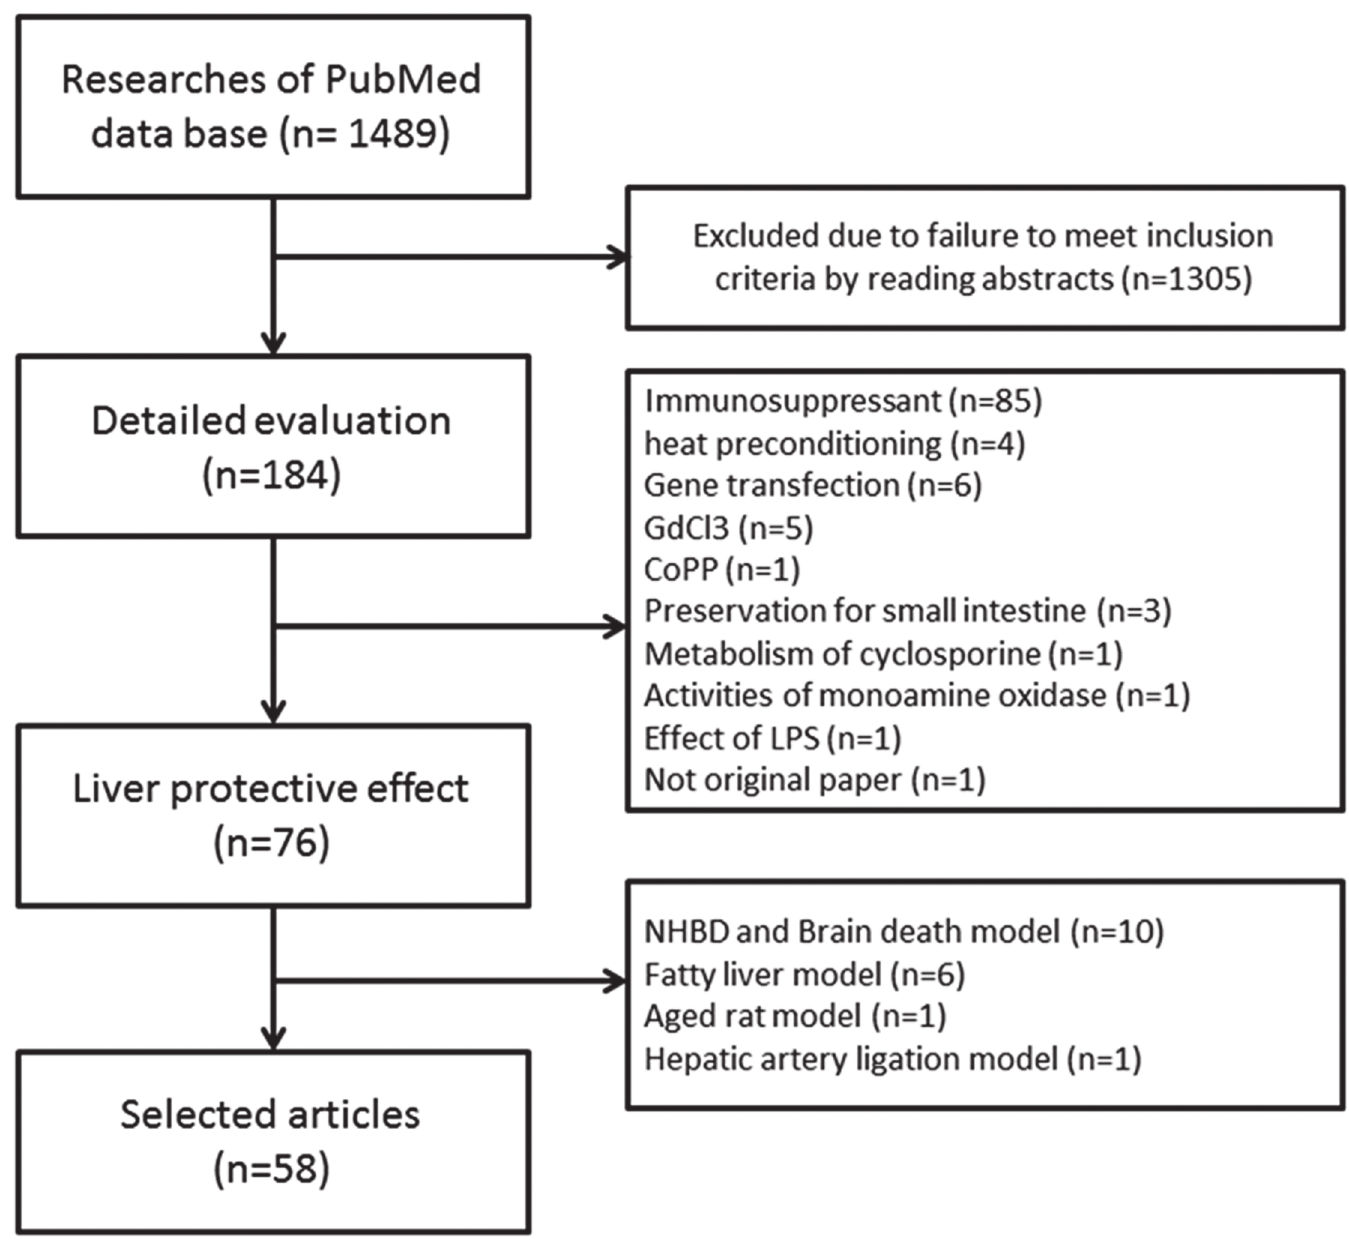
Fig 1. Study flow diagram included in the systematic review.